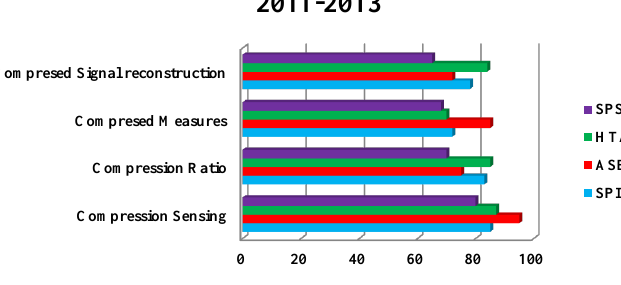
Figure 2: Graphical representation of 2011-2013 review